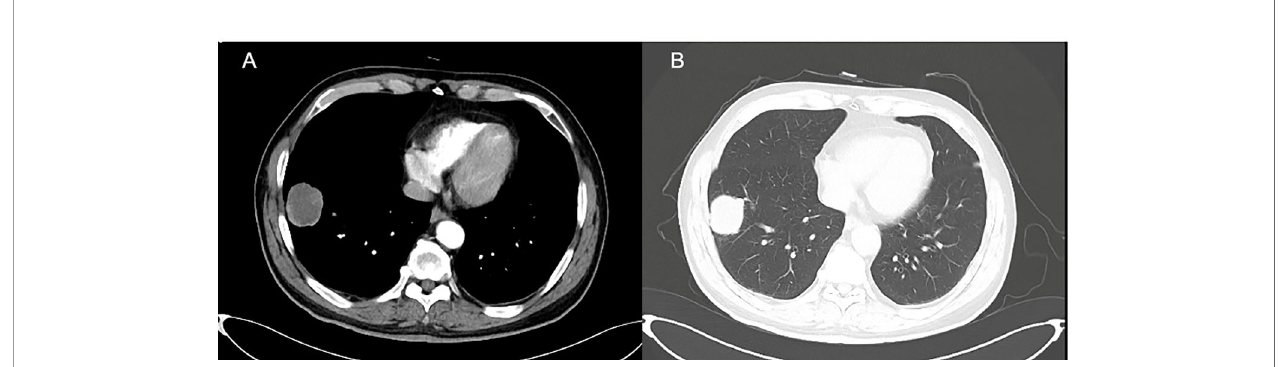
FIGURE 1 | Occupation in the right inferior lobe of lung. (A) lung window, (B) mediastinal